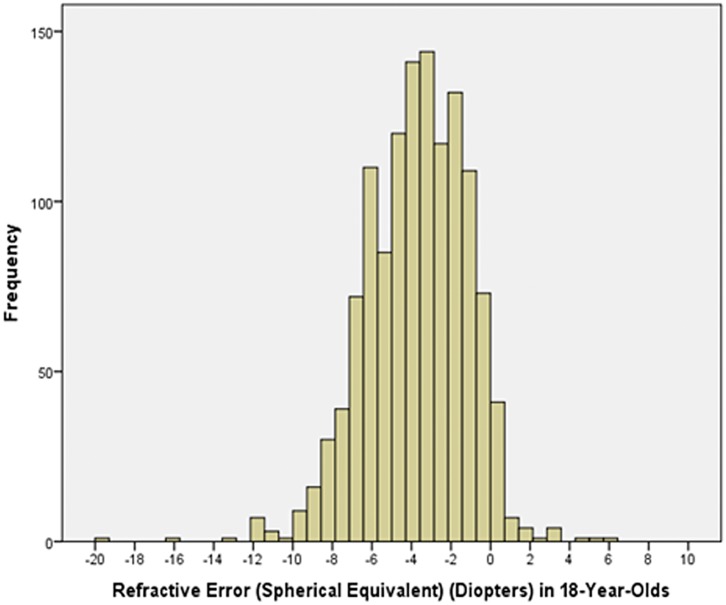
Histogram showing the distribution of refractive error in the 18year-olds in the Greater Beijing School Children Myopia Study 2016.